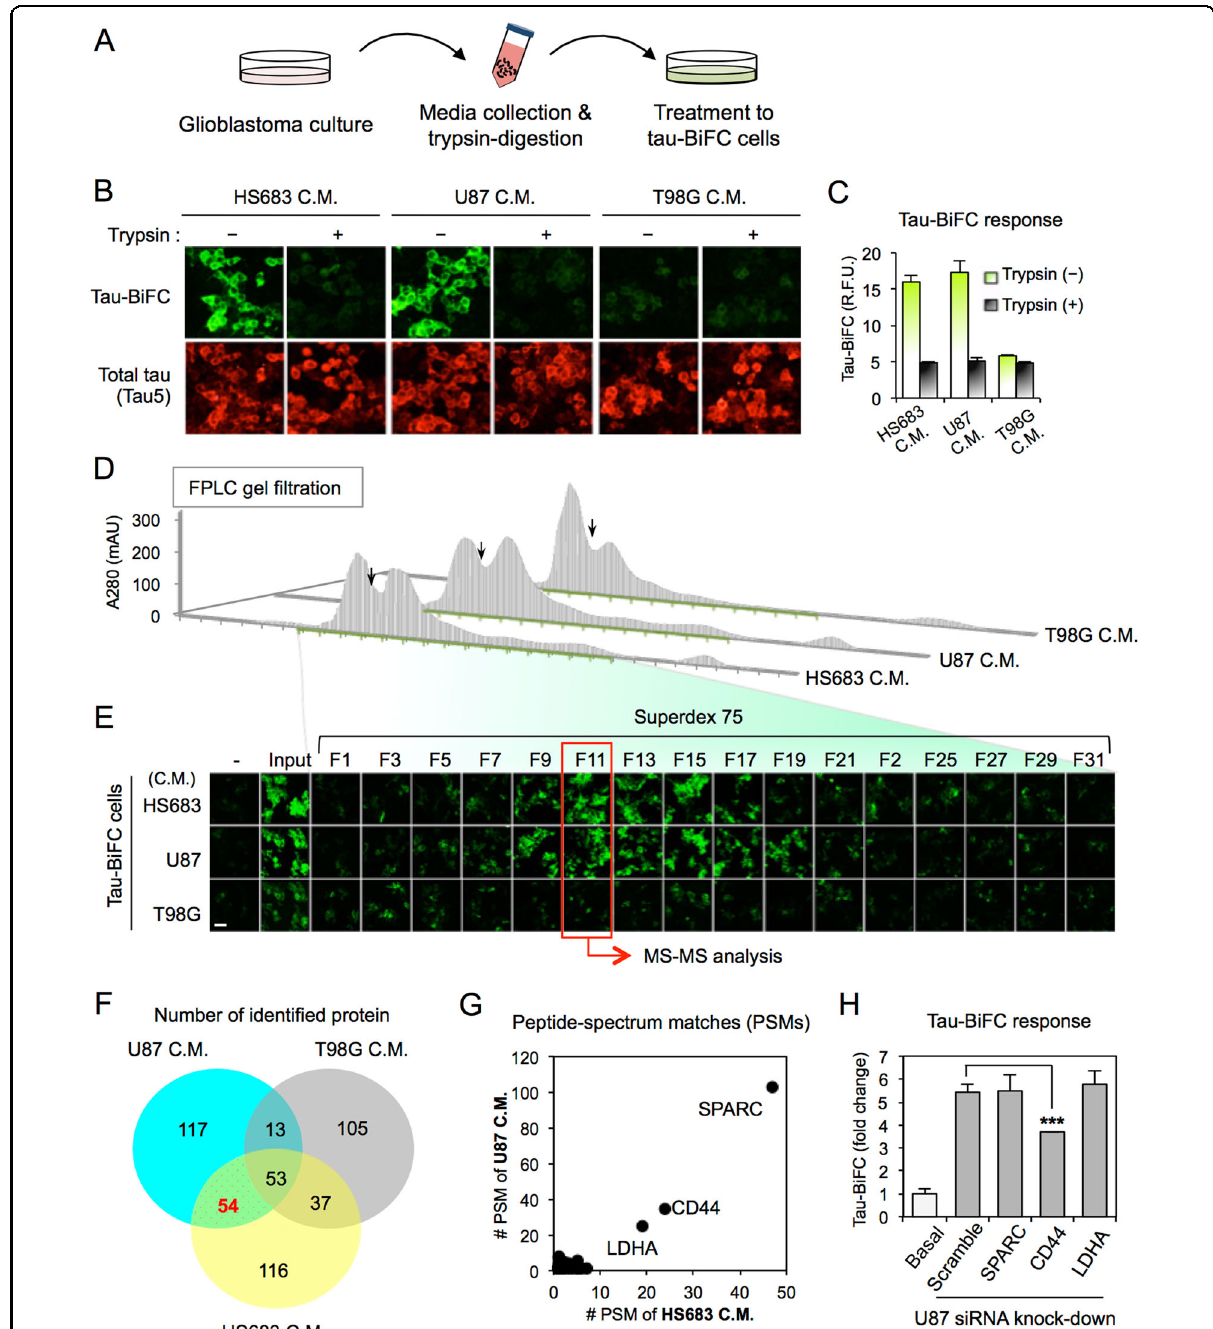
Fig. 3 Secretome analysis identi fi es CD44. a Experimental scheme of collecting glioblastoma C.M., trypsin-digestion, and treatment to tau-BiFC cells. b Tau-BiFC responses and tau immuno fl uorescence images with anti-Tau5 antibody upon the treatment of trypsin-digested or non-digested glioblastoma C.M. Scale bar, 100 µm. c Quanti fi cation of tau-BiFC intensities by using a Harmony 3.1 software. Error bars represent the standard deviation of three independent experiments. d Separation of glioblastoma (HS683, U87, or T98G) C.M. by using FPLC with a Superdex75 gel fi ltration column. e Tau-BiFC responses upon the treatment of odd-numbered FPLC fractions. Fraction 11 of HS683 and U87 showed the highest tau-BiFC responses and was subjected to mass-spectrometry analysis. Scale bar, 100 µm. f Diagram showing the number of identi fi ed proteins. A total of 495 proteins was identi fi ed from the fraction 11 of HS683-, U87-, and T98G-C.M., and 54 proteins were identi fi ed both in HS683- and U87-C.M. but not in T98G. C.M. g Peptide-spectrum matches (PSMs) of 54 proteins. PSM indicates that LDHA, CD44, and SPARC are the three major proteins. h Target validation by siRNA knockdown. U87 cells were transfected with LDHA, CD44, or SPARC siRNA. After 72 h of transfection, U87-conditioned media were collected and treated to tau-BiFC cells. Error bars represent the standard deviation from four independent experiments. The signi fi cance of the experiments was determined with Student ’ s t -test. *** p <